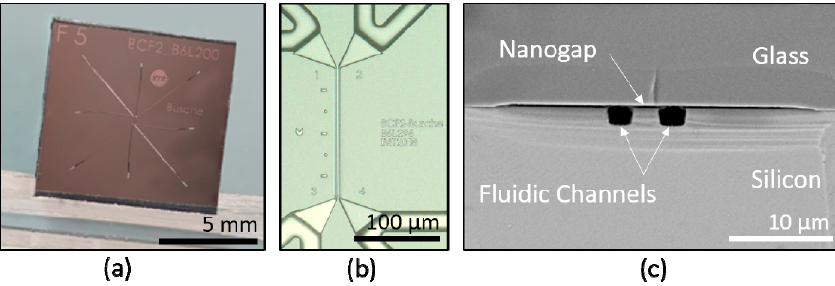
Figure 2. ( a ) Silicon-glass chips with a lateral dimension of 10 × 10 mm after wafer dicing. ( b ) Top view of the nanogap area and the bypass channels. ( c ) SEM image of a cross-section of the nanogap with reference and capture channels.